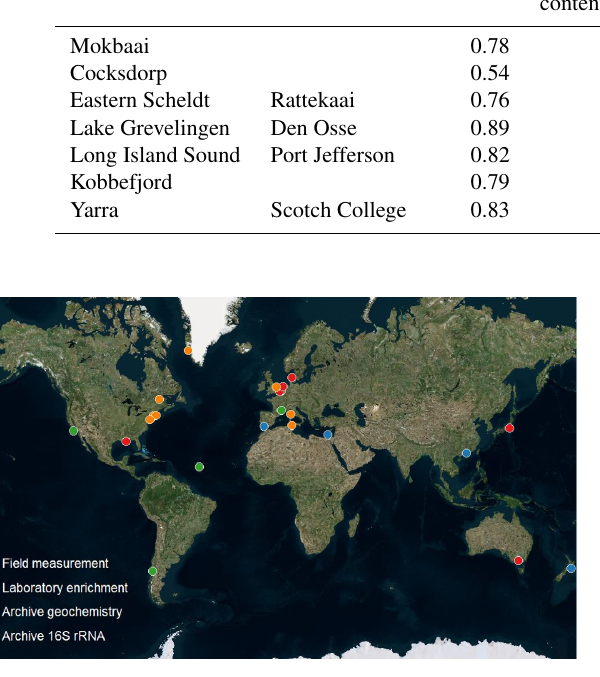
Figure 8. Global distribution of cable bacteria activity and/or pres- ence in marine sediments. The colours of the markers represent the screening method that was used to detect cable bacteria presence or activity. Red markers: direct field observation of cable bacteria activity. Orange markers: cable bacteria activity demonstrated after a laboratory induction experiment. Green markers: published geo- chemical profiles with an e-SOx signature, but which were not in- terpreted as such at the time of publication. Blue markers: sites with reported 16S rRNA sequences that have a >97% similarity to cable